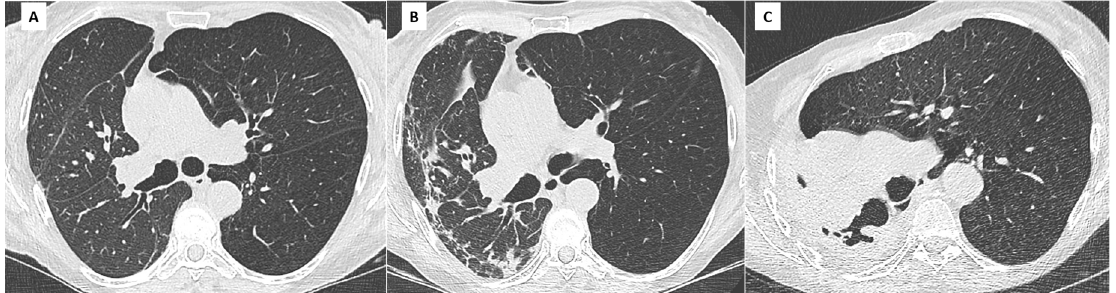
Figure 6. Unilateral RAS in a 61 ‐ year ‐ old woman, who underwent right LT for α 1 ‐ antitrypsin deficiency. ( A ): Baseline CT scan. Note the diffuse hypo attenuation and hypoperfusion of the left native lung, compared to the right allograft. An adapted normal FEV1 must be defined in this patient, taking into account the severe obstruction from the left lung; ( B ) Diagnosis of CLAD, with concomitant apparition of subpleural interstitial opacities in the right lung; ( C ) 3 years later, the allograft has been replaced by dense fibrosis and is totally collapsed. There is marked ‐ over expansion of the left lung.